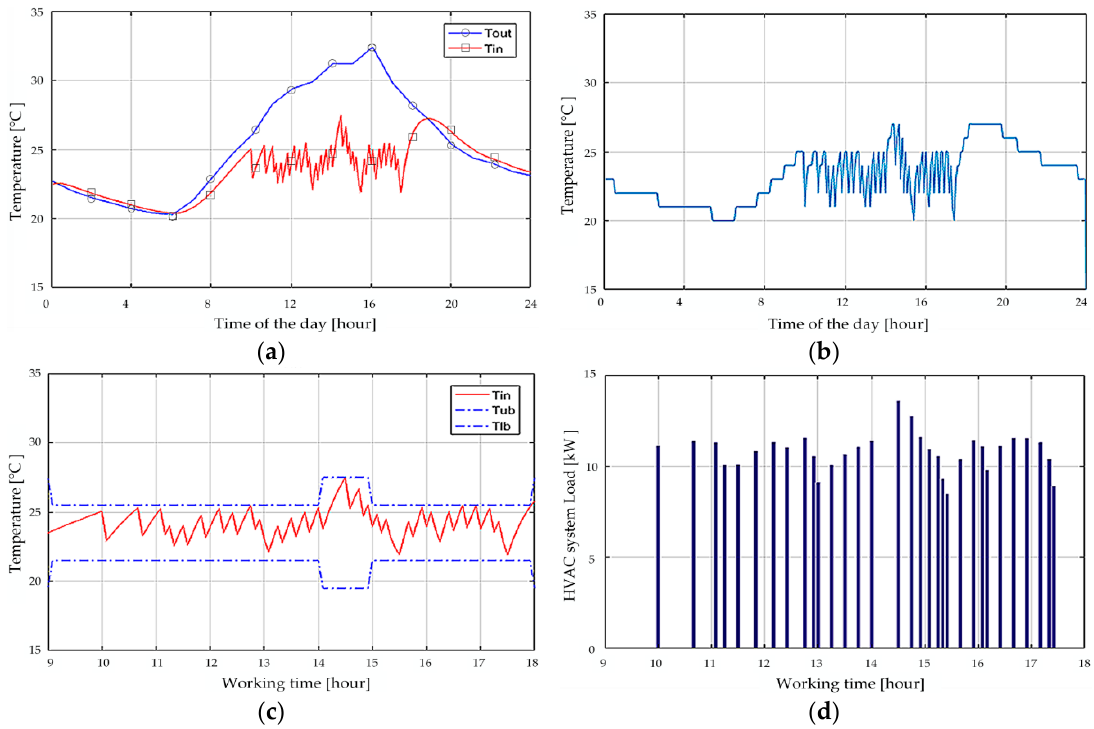
Figure 8. Case 3 simulation results. ( a ) Outdoor temperature and room temperature; ( b ) setting temperature; ( c ) indoor temperature and constraints range (work time); ( d ) HVAC system power (work time). Table 7. Summary of Case 3 simulation results.